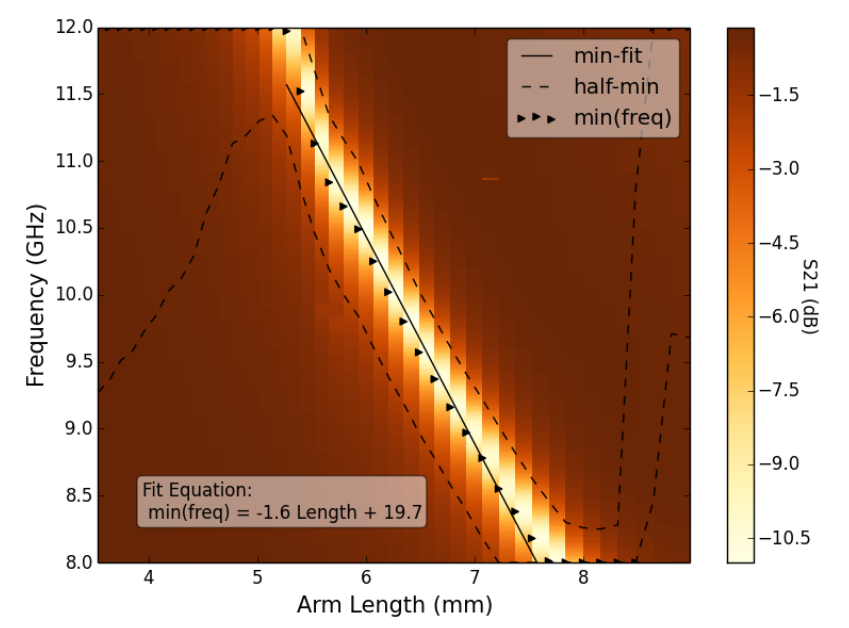
Figure A11. Simulated S 21 RF Response of Spirals with Varying Arm Lengths. Color indicates S 21 in dB, triangles indicate the minimum points and dashed lines indicates half of the minimum value.